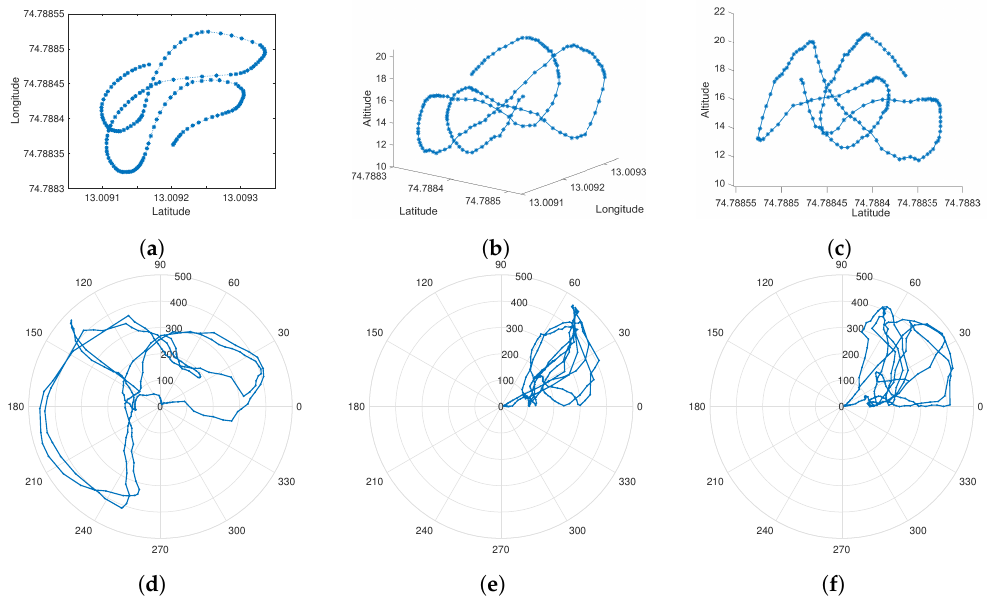
Figure 11. The figure-eight trajectory followed by the kite during the test. The GPS and altitude data were used to plot the trajectory of the kite in 3 dimensions. ( a ) Top view: lat vs. lon. ( b ) 3D view: lat-lon vs. altitude. ( c ) Side view: lat vs. altitude. ( d ) Yaw vs. Force. ( e ) Roll vs. Force. ( f ) Pitch vs.